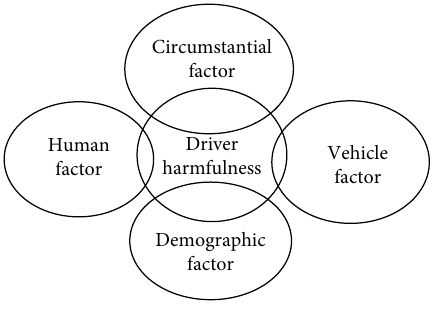
Figure 1: Principal risk